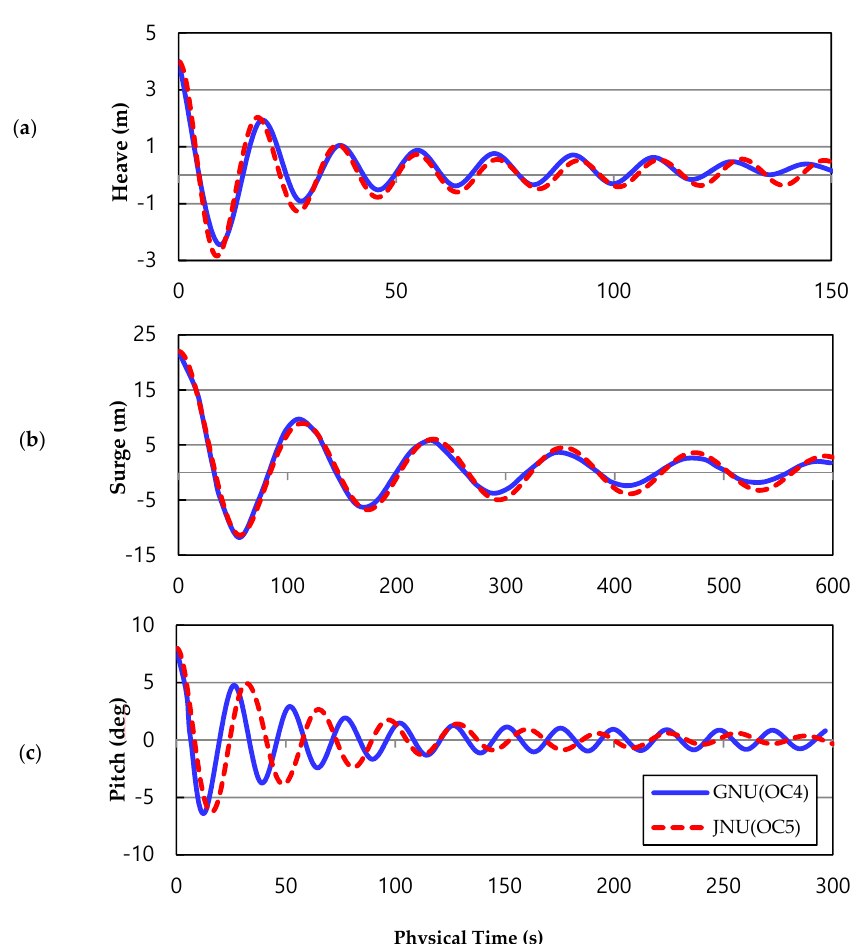
Figure 8. 3-DOF movement of platform by time domain: ( a ) Heave movement; ( b ) Surge movement; ( c ) Pitch movement.